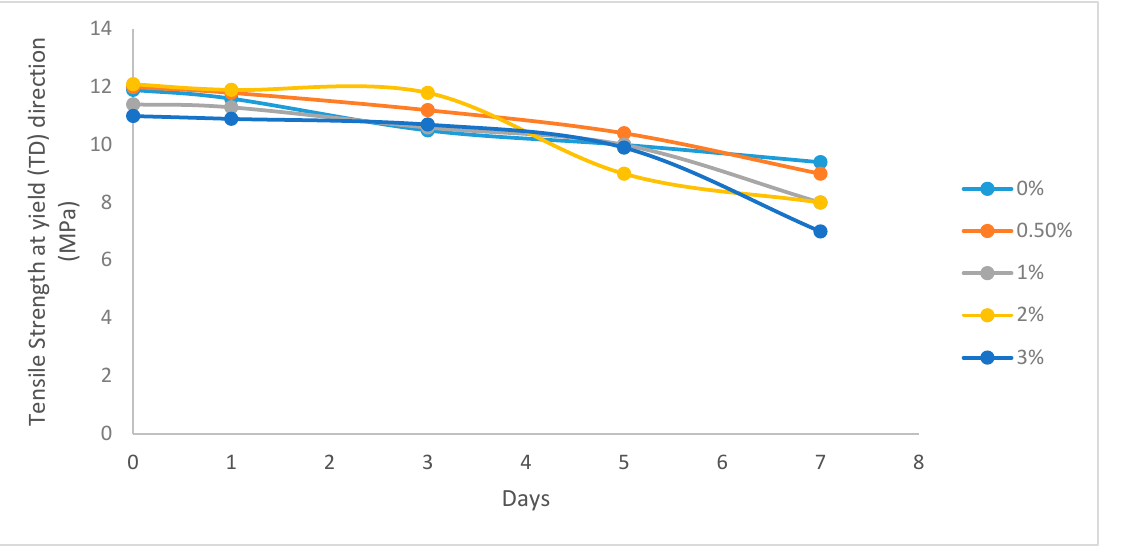
Figure 4. Changes in the tensile strength at yield in transverse direction (TD). Elongation at break is frequently employed to track the degradation process. The variations in elongation at break in both the MD and TD directions of several films throughout treatment are shown in Figures 5 and 6. Figure 5 shows that the highest percentage decrease in elongation at break in MD direction is 21% at 3% pro-oxidant percentage with 7 days of thermo-oxidative treatment, while a higher percentage decrease in elongation at break in TD direction (38.36%) is obtained under the same pre-treatment conditions.